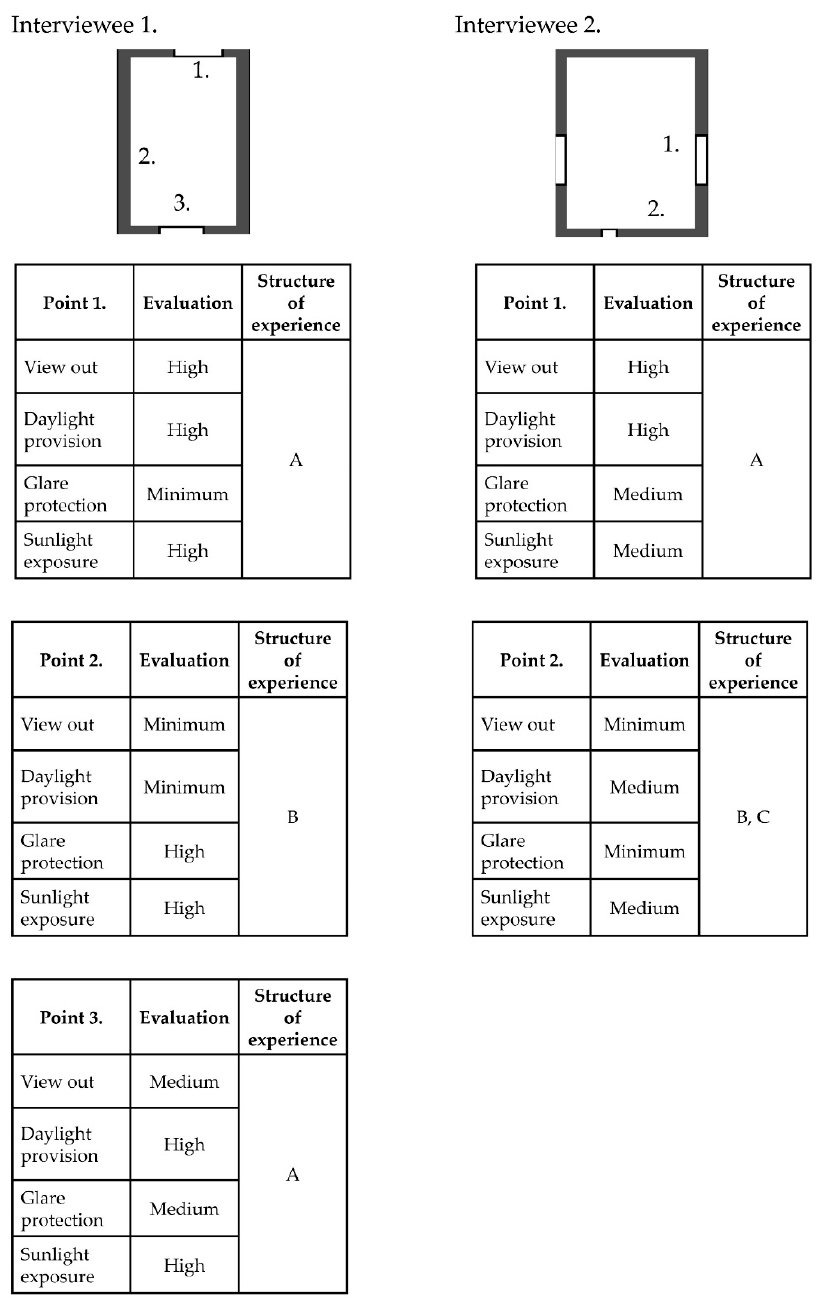
Figure 6. Two fictitious floorplans showing locations of experience of delightful daylighting (point 1, 2, 3) and examples of combining the results of the spatial daylight descriptions according to the EN 17037:2018 and the long-term spatial interviews (A, B, C) for correlation